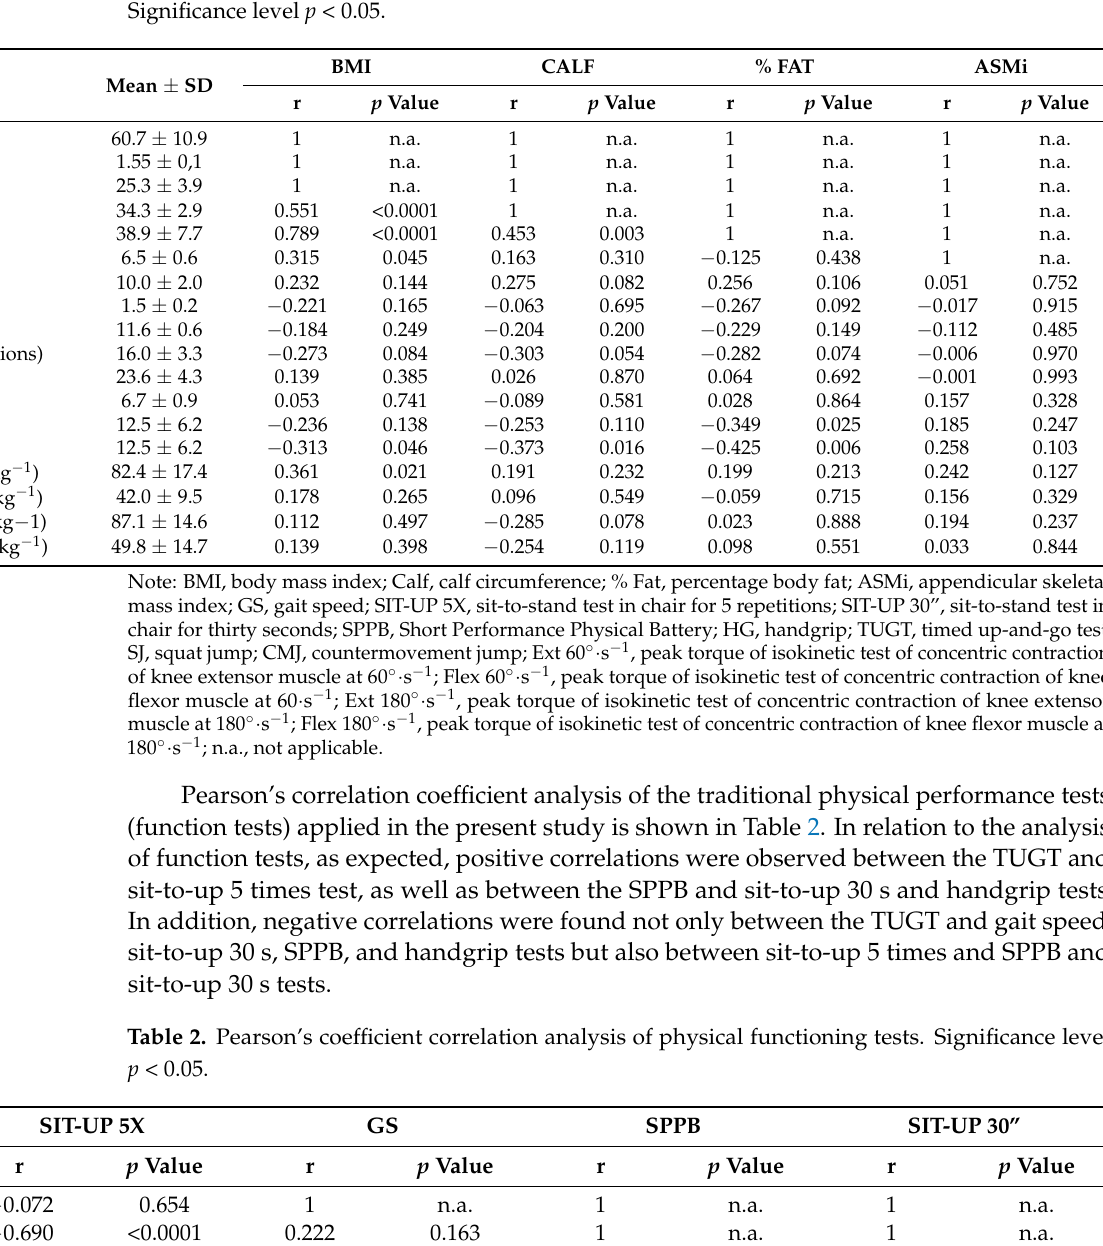
Table 1. Mean and standard deviation of anthropometric characteristics (weight, height, BMI, CALF, % FAT, and ASMi), and physical performance tests of the volunteers enrolled in this study. In addition, Pearson’s coefficient correlation analysis of anthropometrics data and physical performance tests. Significance level p < 0.05.